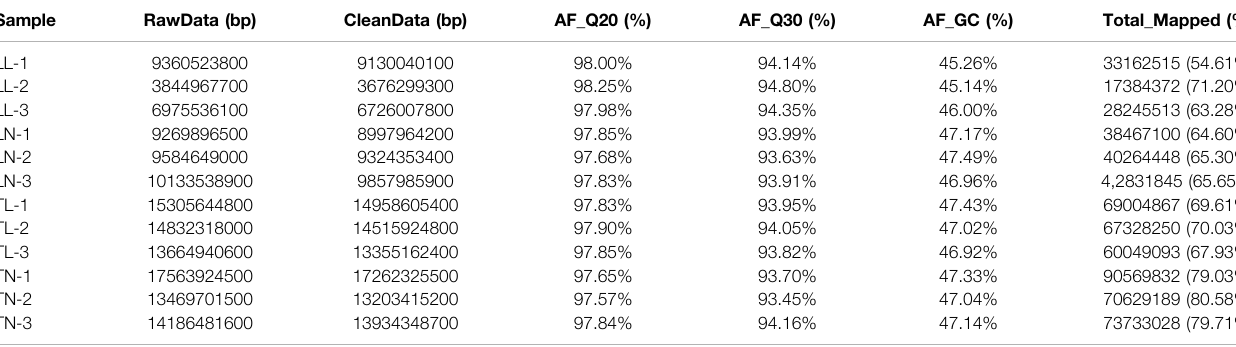
TABLE 1 | Overview of the reads and quality fi ltering of the twelve libraries.